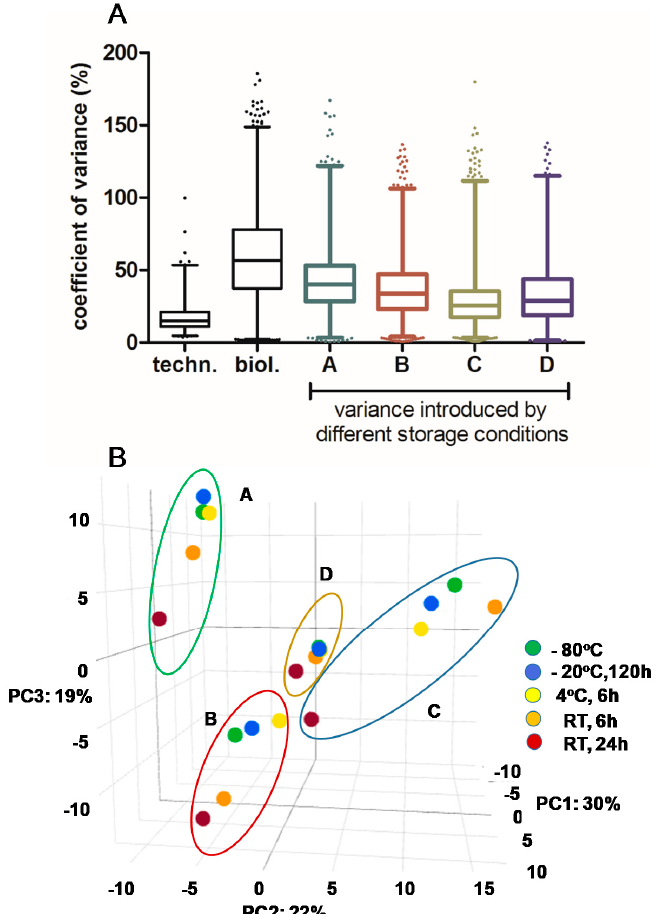
Figure 4. Impact of storage conditions on the whole peptidome. ( A ) Coefficient of variance (CV) in individual breast milk samples A–D due to storage at different conditions in comparison to technical (techn.) and biological (biol.) CVs. Lines indicate median values. Whiskers indicate 1–99 percentile to display outliers. ( B ) Principal component analysis of all peptides per individual sample reveals (i) high variance between the peptide pattern in breast milk from different participants, and (ii) highest effect on the peptide pattern after storage at RT for 24 h.